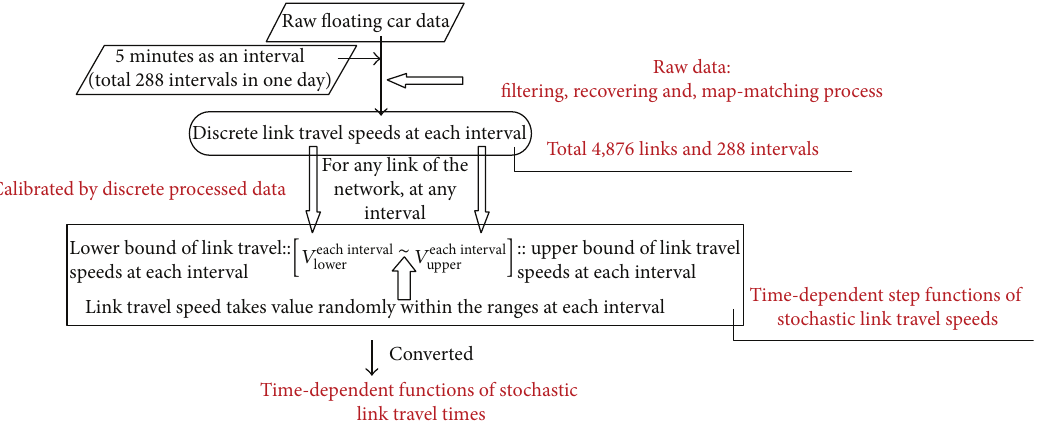
Figure 4: The calibration procedure of stochastic time-dependent travel